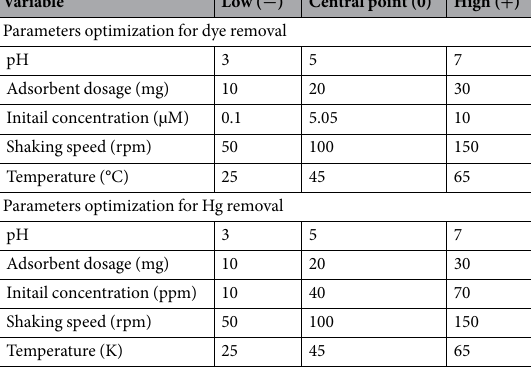
Table 1. Design matrix of the factorial design in the central composite design